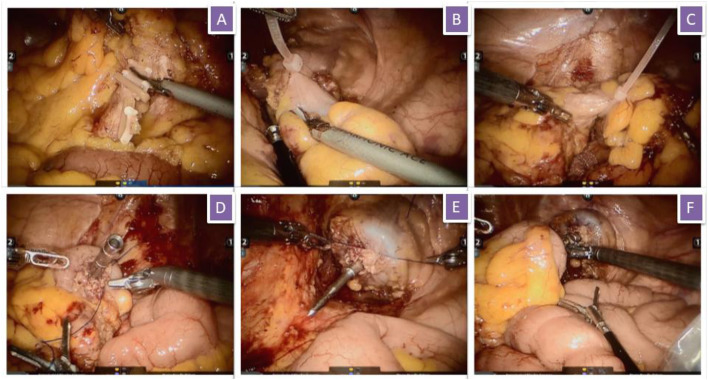
Surgical procedure. (A) The inferior mesenteric artery and vein were isolated and clipped by absorbable vascular clamps; (B) Rectum was ligated with self-locking nylon bandage; (C) Sigmoid colon was ligated with self-locking nylon bandage; (D) Suture the stump of sigmoid colon and put the orvil into the sigmoid colon; (E) Suture the stump of rectum; (F) Complete the anastomosis.